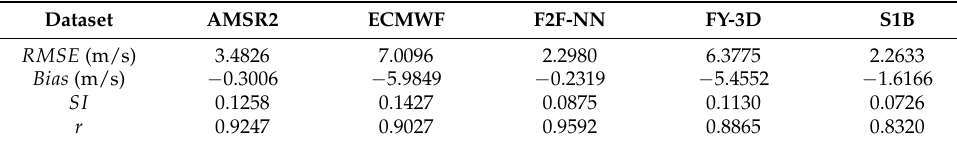
Table 3. Comparison of SFMR wind data with other wind products.